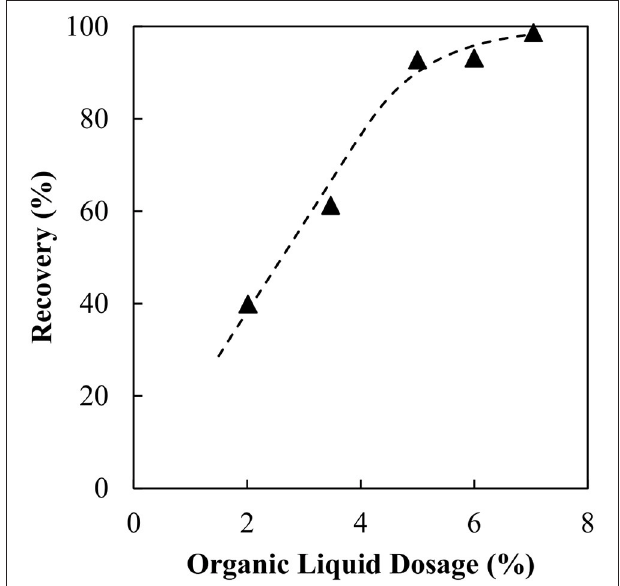
FIGURE 2 | Magnetite recovery as a function of organic liquid dosage.